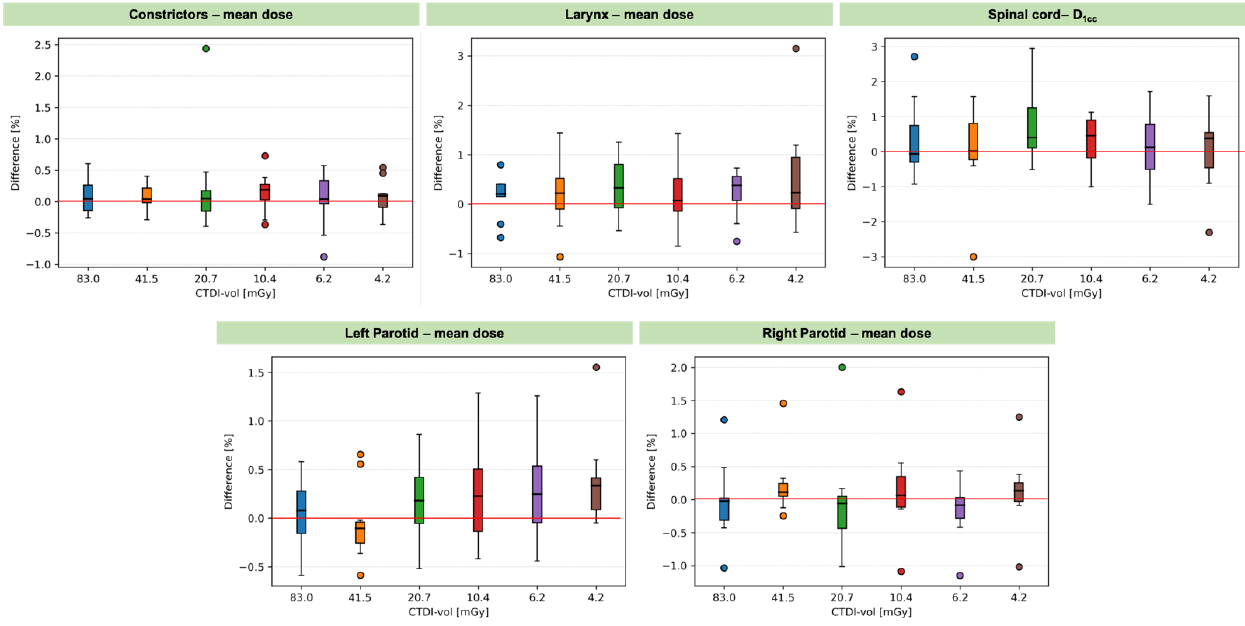
Figure 7. Percentage differences in OAR sparing metrics between low-dose protocols and the reference standard protocol. Boxplots show: median (horizontal bar), Q1–Q3 (25th-75th) percentile (rectangle), 1.5 × (Q3–Q1) interquartile range (whiskers), outliers (dots). Differences of up to 3% in the mean dose ( D mean ) and D 1cc (for the spinal cord) were observed. Similar to the target coverage, there is no trend as the imaging dose decreases.